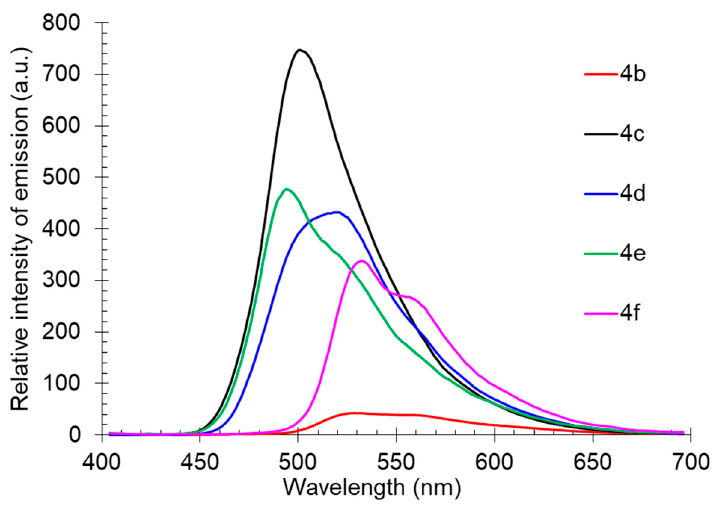
Figure 8. Solid-state photoluminescence spectra of compound 4 in a powder.